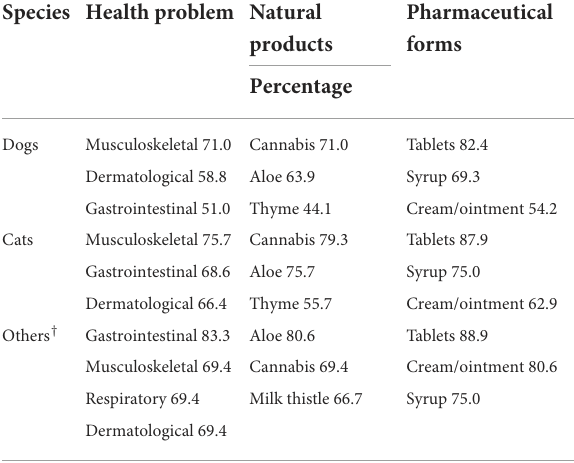
TABLE 6 Types of pharmaceuticals forms used for treatment of the pets by Spanish small animal veterinarians. Pharmaceutical forms